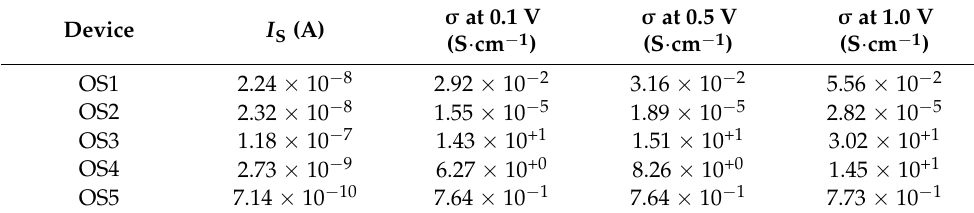
Table 2. Electrical parameters of the devices with OS